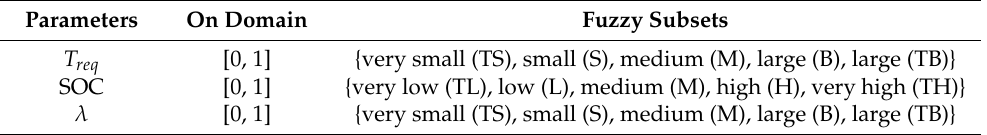
Table 2. Parameters of the fuzzy controller.